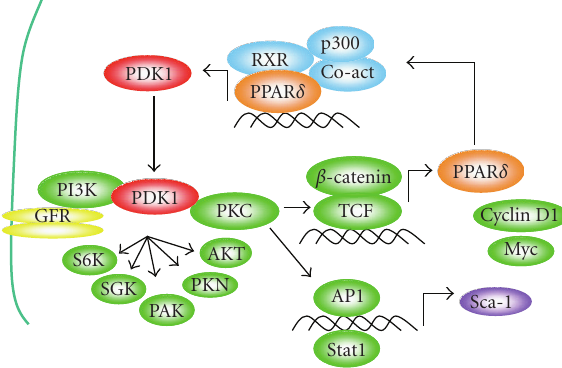
Figure 3: PDK1 and PPAR δ autoregulatory cascade. Growth factor receptor (GFR) activation activates PDK1 leading to PKC α and β - catenin/TCF activation [88]. TCF target genes include cyclin D1, c-Myc, and PPAR δ [75]. PPAR δ transactivates PDK1 [72], which in turn perpetuates the oncogenic signaling cascade. Preliminary data suggests that PDK1 maintains the expression of the murine stem/progenitor cell marker, stem cell antigen-1 (Sca-1), which is under the control of AP1 and Stat1